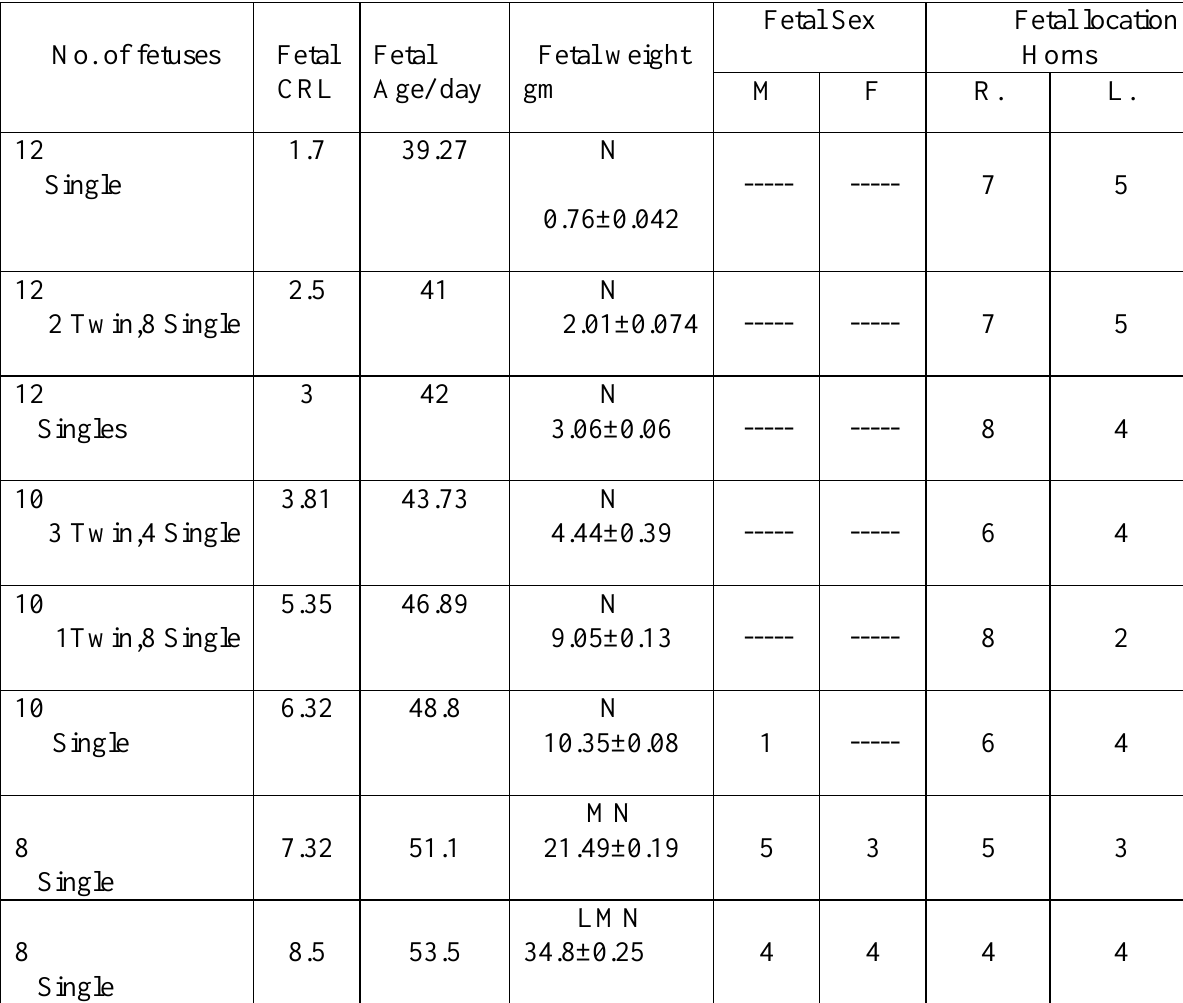
Table 1: The relation of ovine fetus weight (gm), fetal sex and fetal location in various fetal ages(in days) in single and twin Pregnancy(±